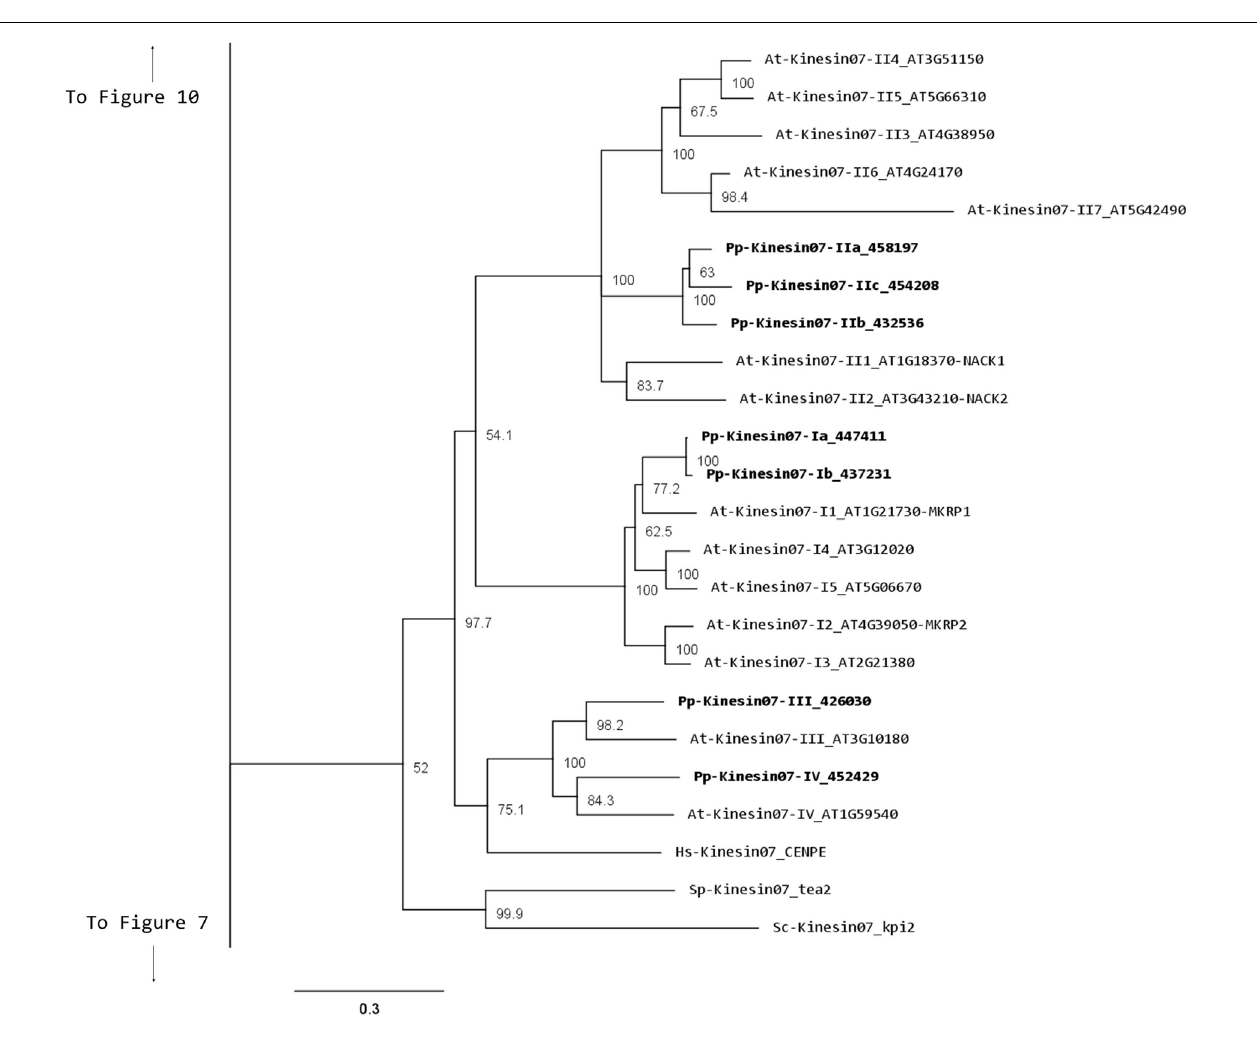
the statistical support of values above 50%.The scale shows the estimated branch length corresponding to the number of substitutions per site.The Physcomitrella numbers correspond to the Phypa number uniquely associated with each gene model (version 1.6) at